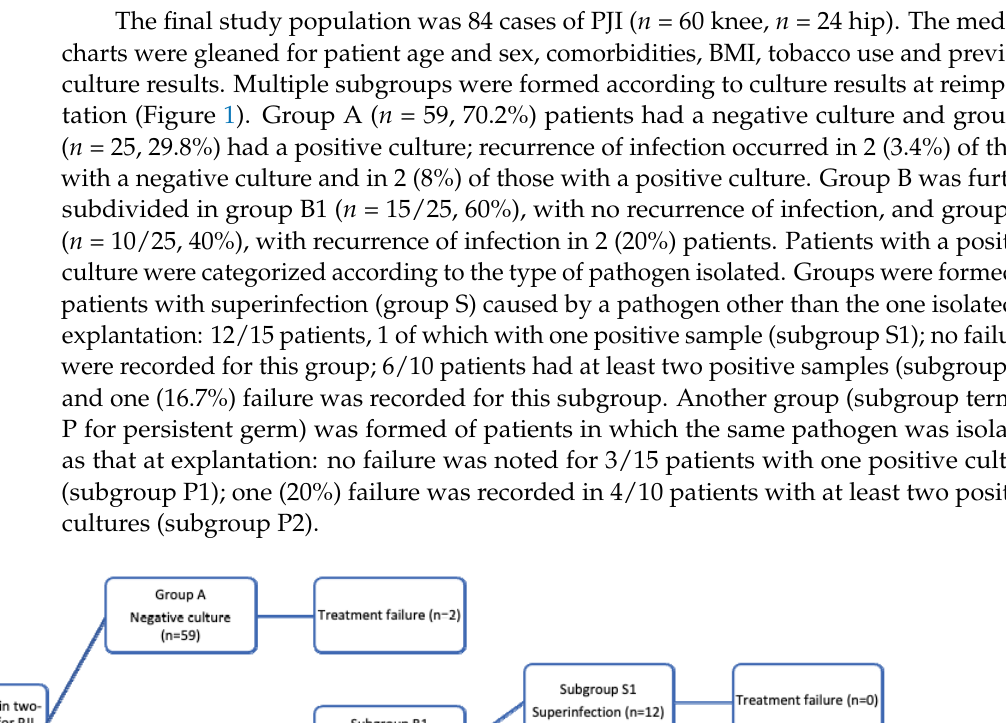
outcome were analyzed.